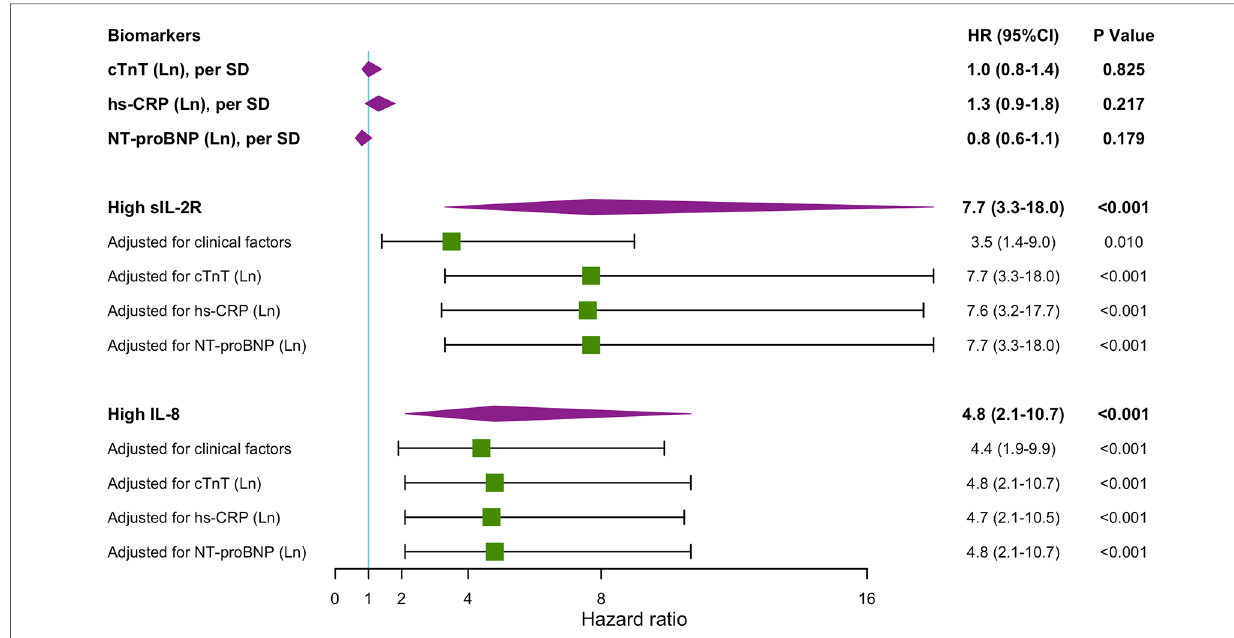
FIGURE 3 Hazard ratios for MACEs 1-year follow-up. Unadjusted and adjusted hazard ratios (HRs) obtained by Cox regression analyses for MACEs during 1-year follow-up when having high sIL-2R (greater than the cutoff value 807 U/ml) and high IL-8 (greater than the cutoff value 32.5 pg/ml) levels during hospitalization. sIL-2R and IL-8 was measured after a 12-h overnight fast on the second day of admission of CCU. clinical factors include: heart rate, systolic blood pressure, smoker, diabetes mellitus, hypertension, hypercholesterolemia, coronary artery disease, heart failure, history of PCI or CABG, history of stroke, renal insuf fi ciency, anemia, total cholesterol, HDL cholesterol, fasting blood sugar. CABG, coronary artery bypass grafting; CCU, coronary care unit, cTnT, cardiac troponin T; hs-CRP, high sensitivity C reactive protein; IL, interleukin; Ln, natural logarithm; MACEs, major adverse cardiovascular events; MI, myocardial infarction; NT-proBNP, N-terminal pro-brain natriuretic peptide; PCI, percutaneous transluminal coronary intervention; SD, standard deviation; sIL-2R, soluble IL-2